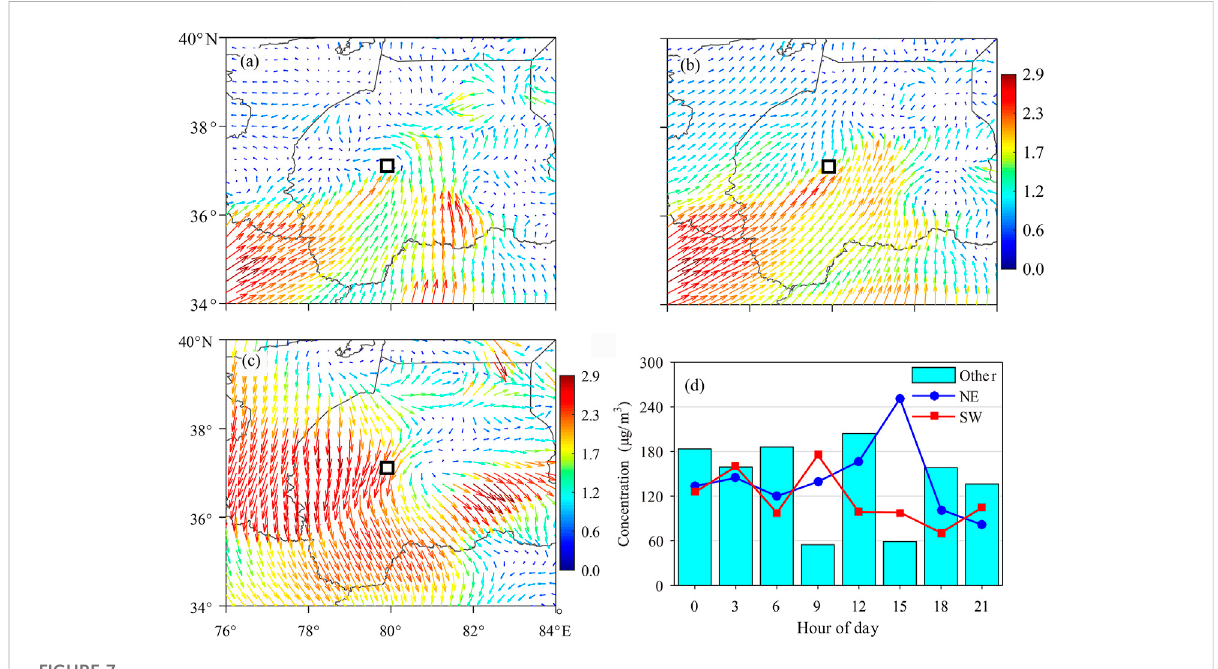
FIGURE 7 Average 10-m wind fi elds (m · s − 1 ) at (A) 0200 BJT (Beijing Time), (B) 0800 BJT and (C) 1400 BJT in Hotan area in January of 2013 – 2019. (D) Diurnal variations of average PM 2.5 concentration in southwesterly wind direction (red line), northeasterly wind direction (blue line) and other wind directions (cyan